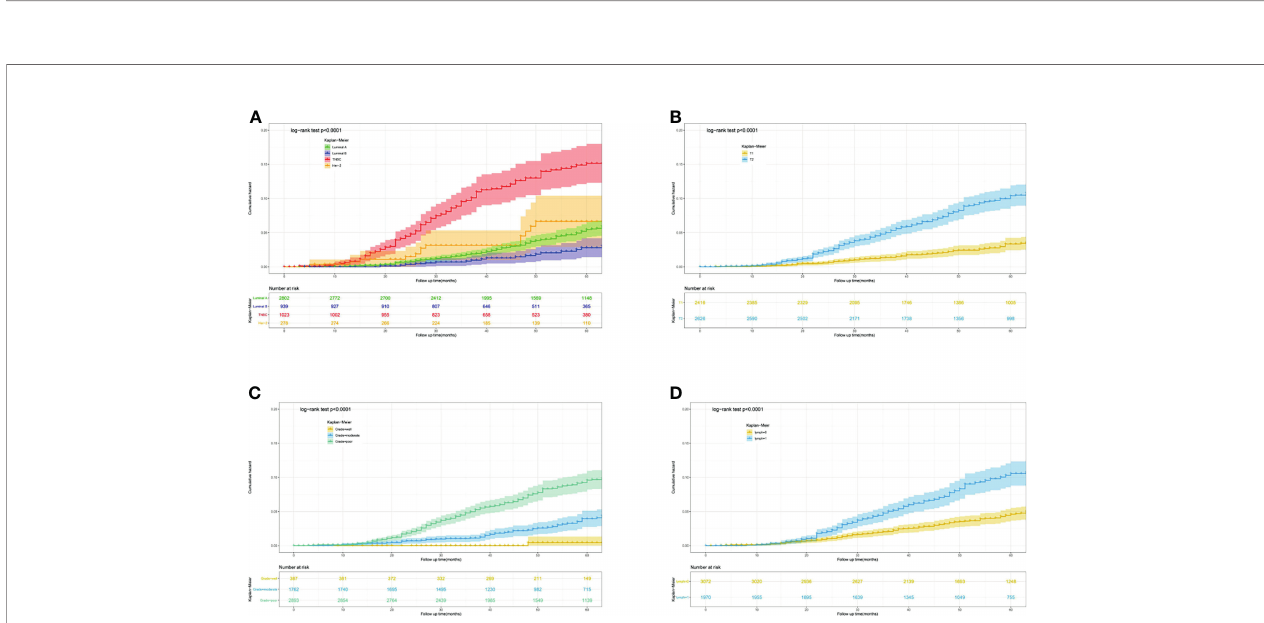
FIGURE 2 | Predicting the 3-, 5- year cumulative hazard of cancer-speci fi c death risk in young women with early-stage breast cancer. (A) different molecular subtype; (B) tumor size; (C) differentiation grade; (D) lymph node